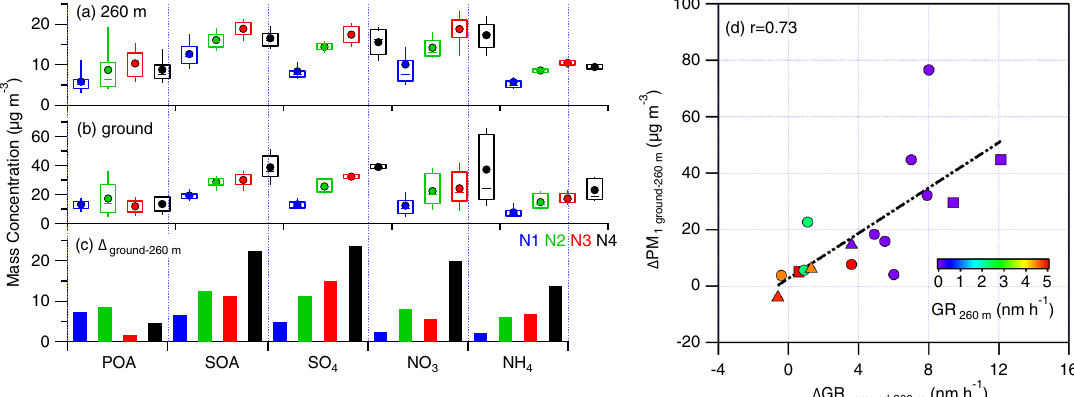
Fig. 3 Haze ampli fi cation and particle growth events. Primary organic aerosol (POA), secondary organic aerosol (SOA), sulfate (SO 42 − ), nitrate (NO 3 − ), ammonium (NH 4 + ) at a 260 m and b ground level during four nights (18:00 – 6:00) from September 14 to 18, 2015. N1, N2, N3, N4 were 18:00 September 14 – 6:00 September 15, 18:00 September 15 – 6:00 September 16, 18:00 September 16 – 6:00 September 17, 18:00 September 17 – 6:00 September 18, respectively. The mean (diamonds), median (horizontal line), 25th and 75th percentiles (lower and upper box), and 10th and 90th percentiles (lower and upper whiskers) are shown in the box. c The differences of average mass concentrations between the two heights ( Δ ground-260m ). d Relationship between the differences of PM 1 mass concentrations ( Δ PM 1ground-260m ) between ground and 260 m versus those of particle growth rates ( Δ GR ground-260 m ) in autumn 2015 (circle), winter 2016 (square), and summer 2017 (triangle). The points are colored by the particle growth rates at 260 growth at ground level, accompanied by the inef fi cient vertical differences between the two heights during nighttime, the transportation (Figs 1 and 3). On the fi rst night of the haze cycle concentrations being 13.2 and 7.2 µg m − 3 higher at ground level, (September 14 to 15), growth of primary particles was observed at respectively. These results demonstrate the importance of both heights. However, the faster growth at ground level (3.4 nm h − 1 secondary aerosol mass production associated with the particle